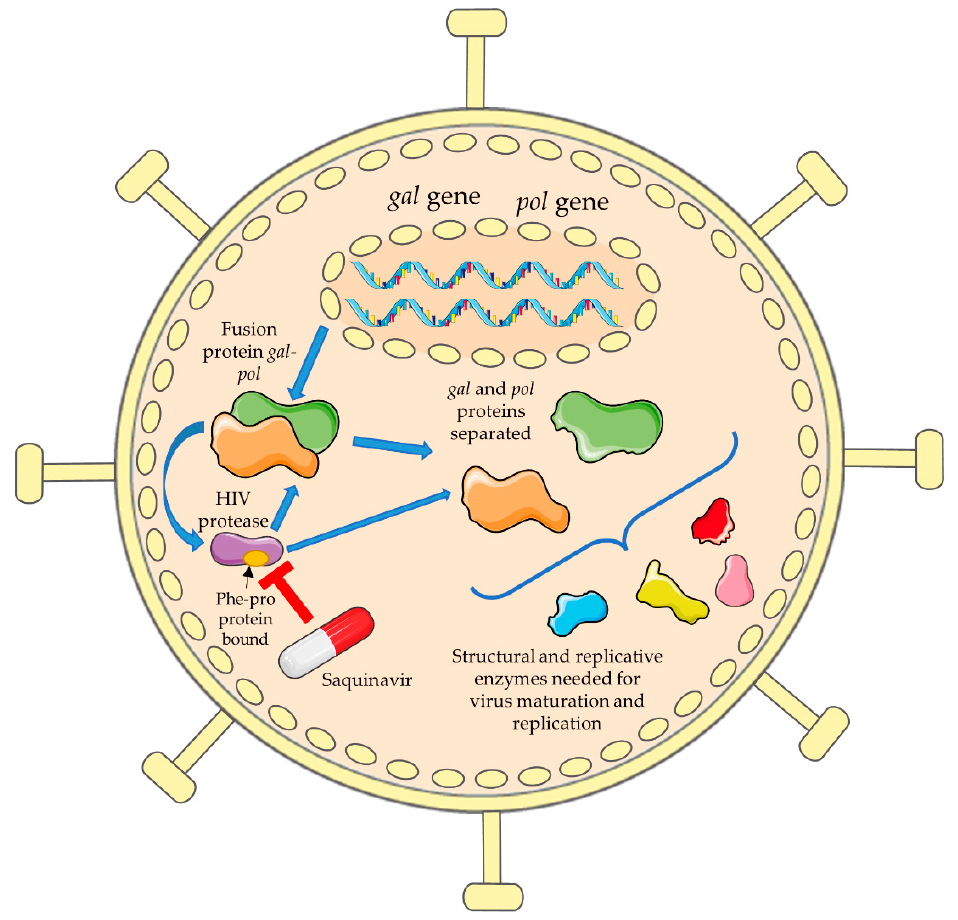
Figure 2. Mechanism of action of saquinavir in the HIV. Viral replication in the HIV can only happen after the translation of a fusion protein between the pol and gag genes. The HIV protease is formed here, where it cleaves itself from this big fusion protein and then cleaves the fusion protein into precursor proteins and then into structural and replicative enzymes. Saquinavir is a mimetic of the Phe–Pro peptide bond, which binds strongly to the protease, leading to competitive inhibition of its activity (this figure was partly generated using Servier Medical Art provided by Servier licensed